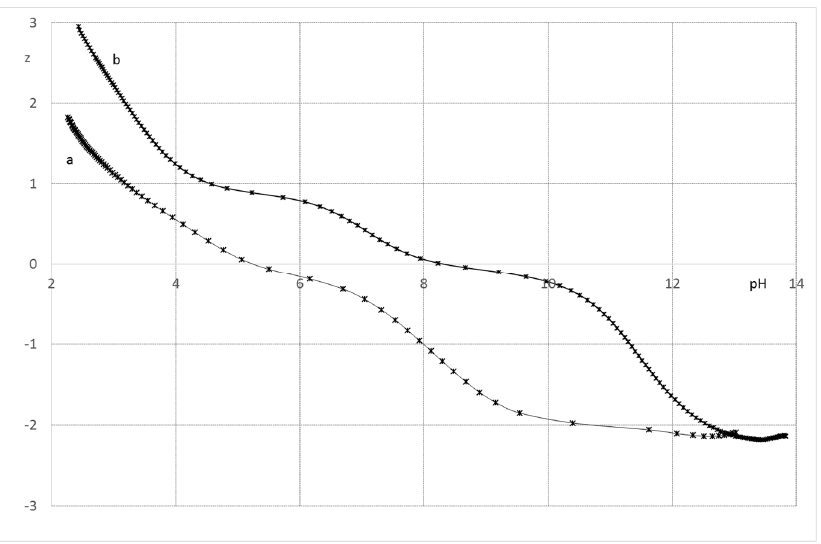
− 1 ; T = 298 K. ( a ) 1 ; ( b ) 2